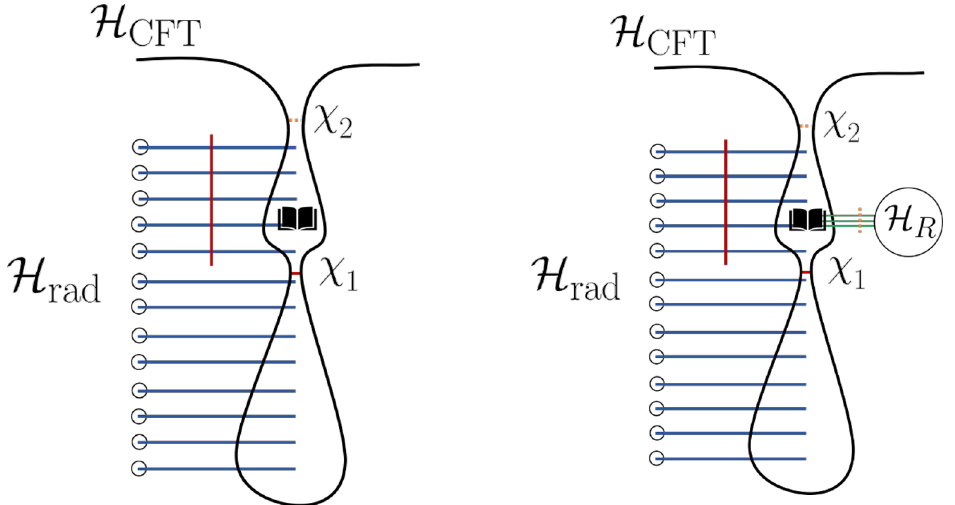
Figure 15. If a heavy diary, left, is thrown into the black hole, it can only be reconstructed from H rad once the generalised entropy (solid lines) of the surface (cid:31) 1 for H rad is greater than the generalised entropy (dotted lines) of the surface (cid:31) 2 . The generalised entropy of (cid:31) 1 has contributions from both the area term and the entropy of Hawking radiation emitted after the diary was thrown into the black hole. In contrast, so long as the diary has small entropy, the surface (cid:31) 2 only has a contribution from its area, plus an O (1) bulk entropy correction. However, if the diary also has a large entropy (right), the diary also needs to be in the entanglement wedge, even when it is in a highly mixed state, or is entangled with a reference system. This increases the generalised entropy of (cid:31) 2